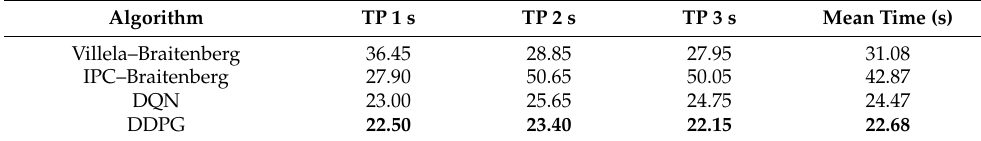
Table 7. Arrival time for the three target points for the experiment with obstacles.